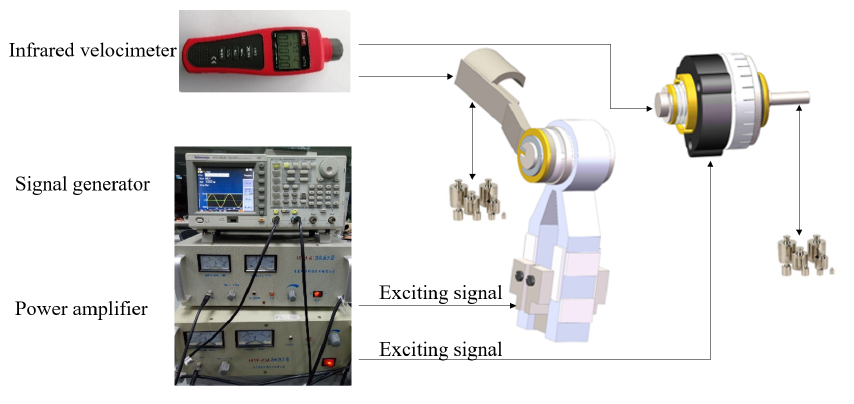
Figure 15. Experimental platform for output characteristics of the ultrasonic motors.